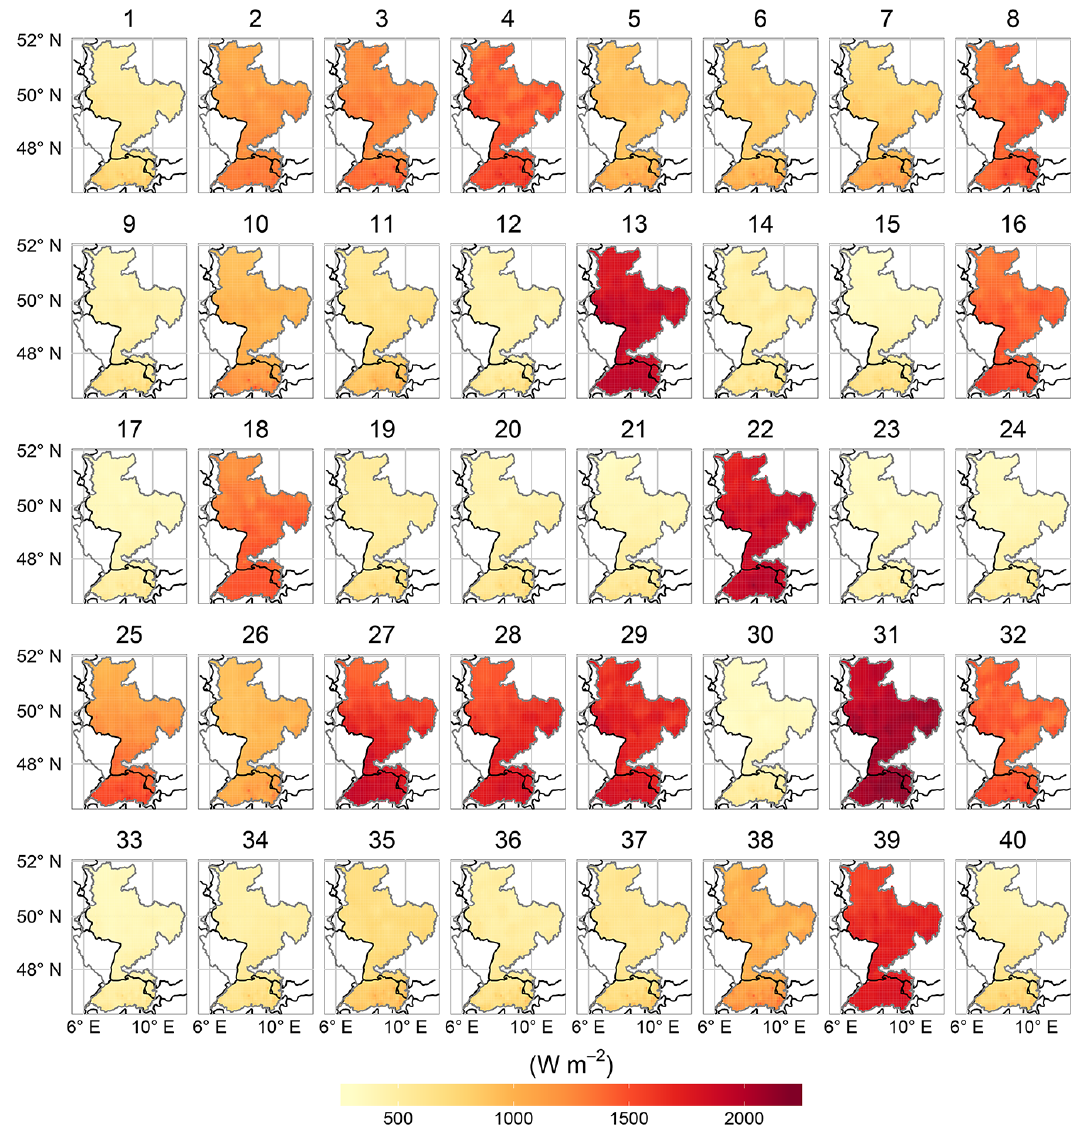
Figure A3. As in Fig. A1 but for global